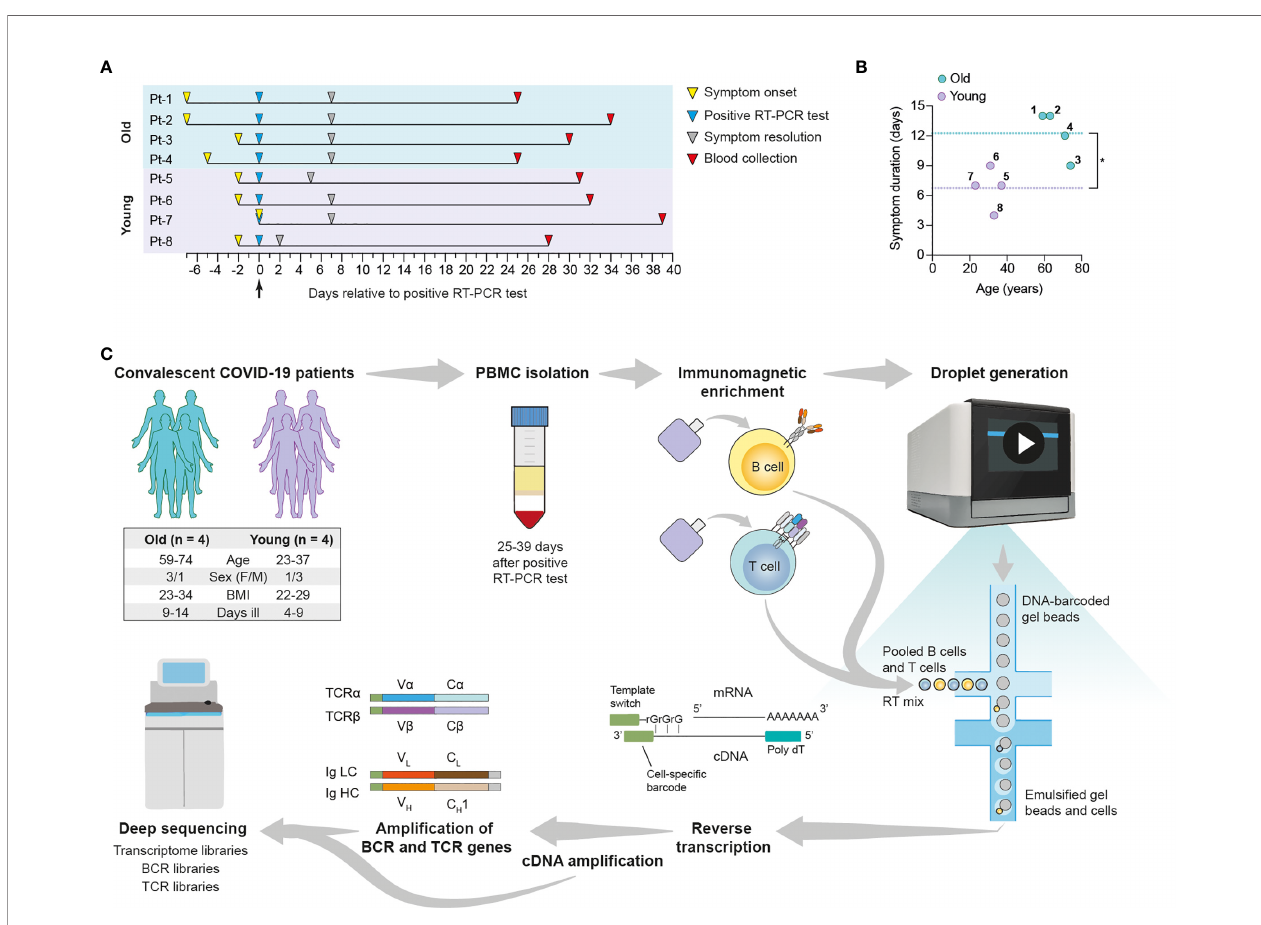
FIGURE 1 | Overview of single-cell transcriptome and immune receptor pro fi ling of convalescent COVID-19 patient lymphocytes. Convalescent COVID-19 patients enrolled in the SERO-BL-COVID-19 study were selected according to their age for single-cell sequencing analysis of their T cells and B cells. (A) Timeline illustrates symptom onset, symptom resolution and collection of blood samples from individual patients relative to the time of positive SARS-CoV-2 RT-PCR test (day 0). (B) Graph displays the ages and duration of COVID-19 symptoms in individual patients. Dotted lines show the mean duration of symptoms in the young (y = 6.75 days) and old (y = 12.25 days) groups. A signi fi cant difference in symptom duration between groups is indicated with an asterisk (p = 0.0127; unpaired t-test). (C) Single-cell sequencing protocol. Whole blood was collected following the resolution of COVID-19 symptoms and subjected to density gradient separation for isolation of PBMC. T cells and B cells from individual patients were puri fi ed from PBMC using negative immunomagnetic enrichment, pooled (intra-patient) and prepared for droplet generation using the 10x Genomics Chromium system. Single cells were emulsi fi ed with DNA-barcoded gel beads and mRNA transcripts were reverse-transcribed within droplets, resulting in the generation of fi rst-strand cDNA molecules labelled with cell-speci fi c barcodes at their 3 ’ ends (added by template switching). Emulsions were disrupted and cDNA was ampli fi ed by means of PCR for further processing of transcriptome libraries. Transcriptome libraries from individual patients were indexed and multiplexed for deep sequencing using the Illumina NovaSeq platform. Targeted enrichment of recombined V(D)J transcripts was performed by PCR and the resulting products were processed for the generation of BCR and TCR libraries, which were then indexed, multiplexed and